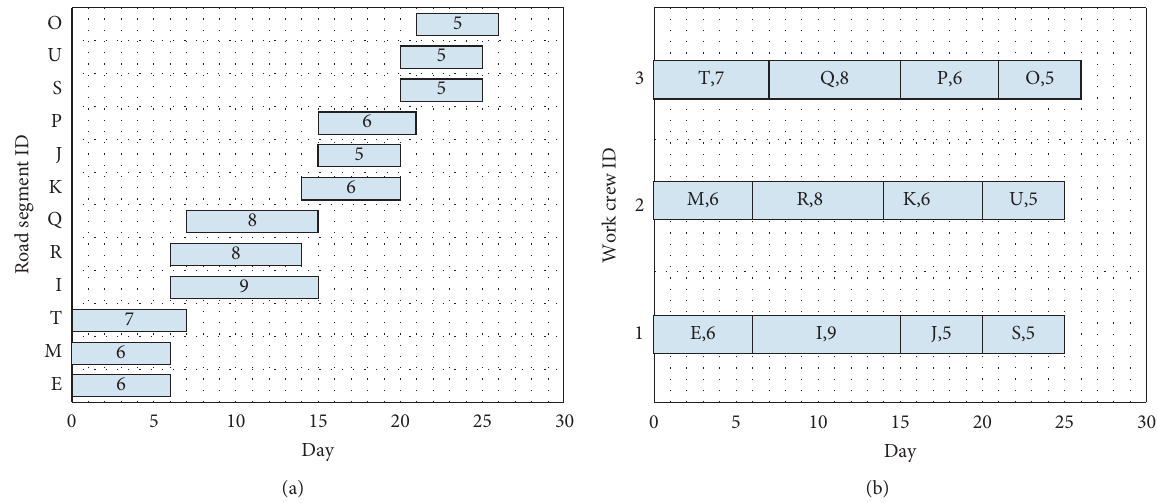
Figure 7: Optimal restoration strategy: (a) time sequence of maintenance; (b) job sequence of work crews.